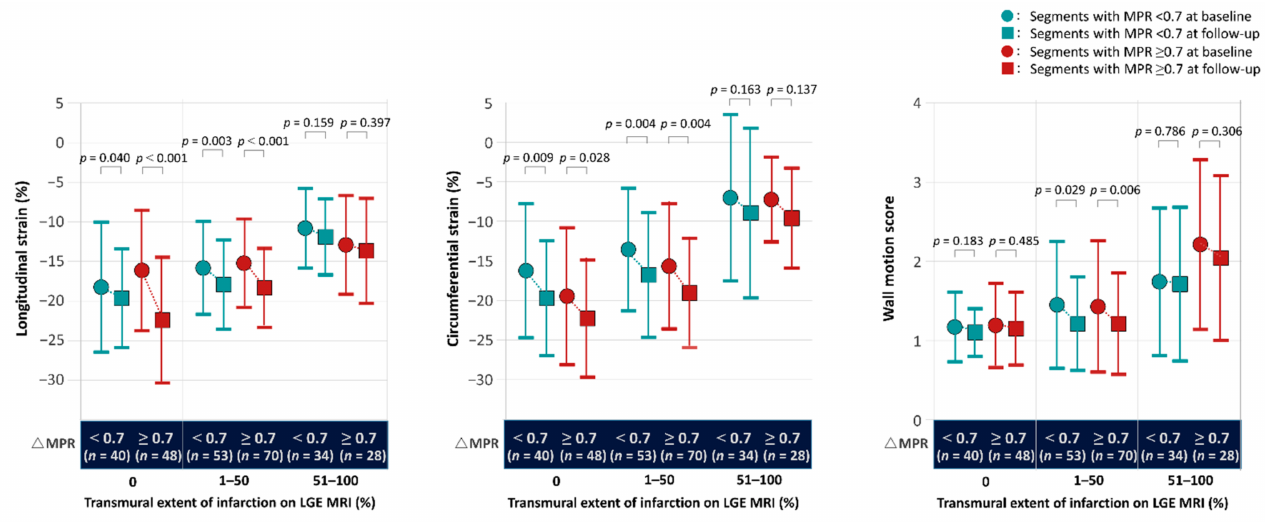
Figure 3. Changes in strain parameters stratified by %LGE and changes in MPR from baseline to follow-up. Abbreviations: LGE, late gadolinium enhancement; MPR, myocardial perfusion reserve; MRI, magnetic resonance